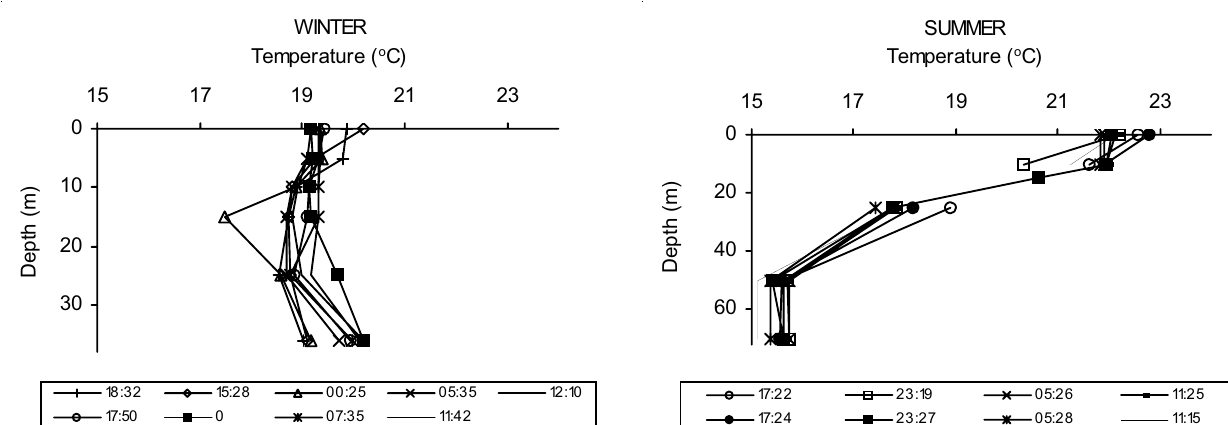
Fig. 2. Fluctuation of water temperature at different times of the day, in winter (23 o 35.6´S/ 44 o 59´W) and summer (23 o 51.3´S/ 44 o 47.6´W) 1988, on the shelf off